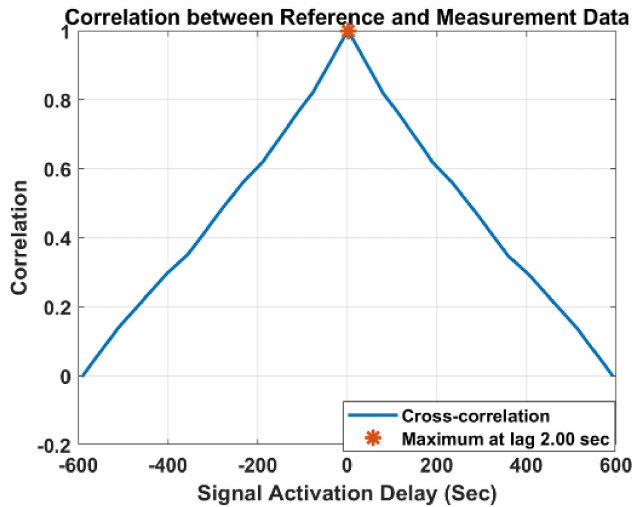
Figure 17. The correlation between reference and measurement current